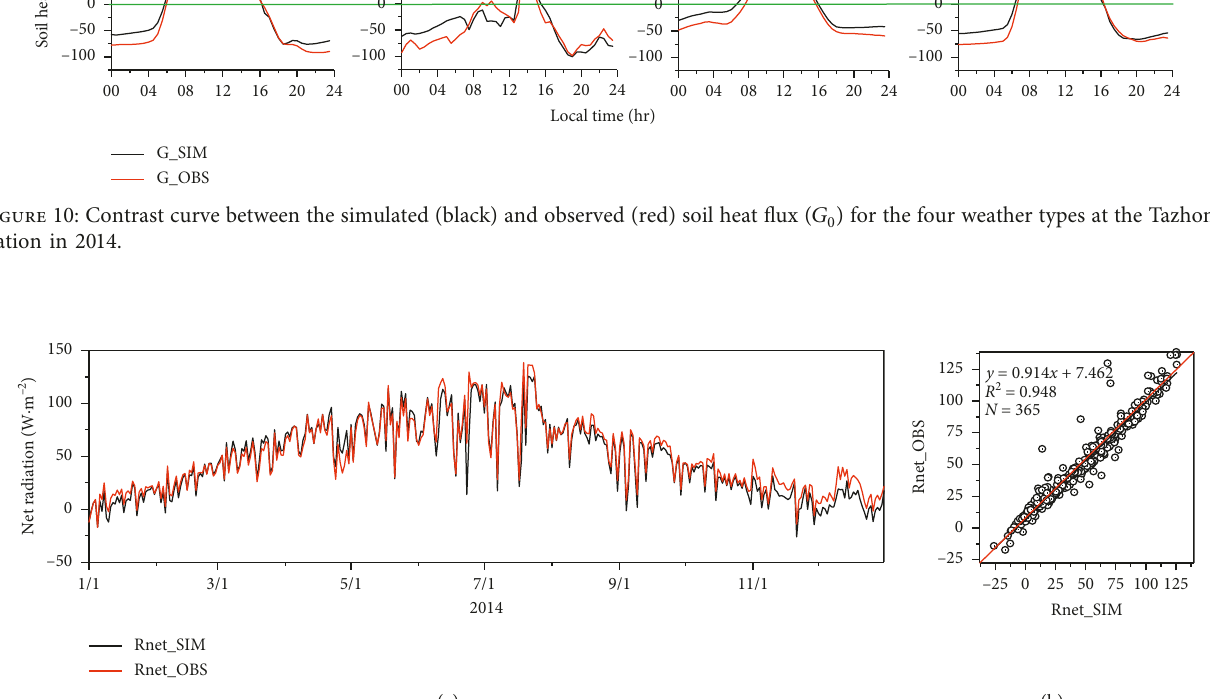
net ) at the Tazhong station in